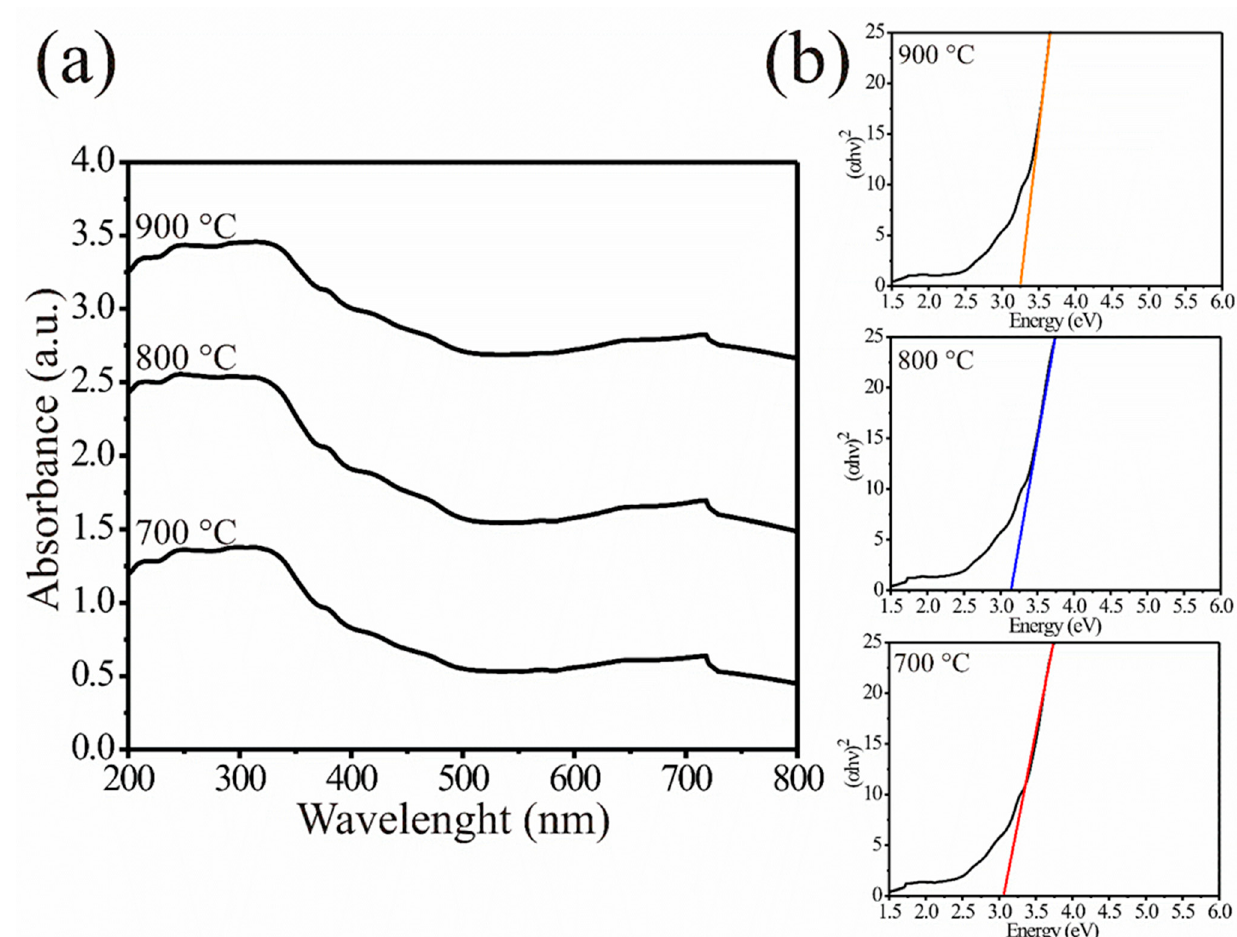
Figure 5. ( a ) UV–Vis spectra of NiSb 2 O 6 , ( b ) determination of the forbidden band at the different calcination temperatures.